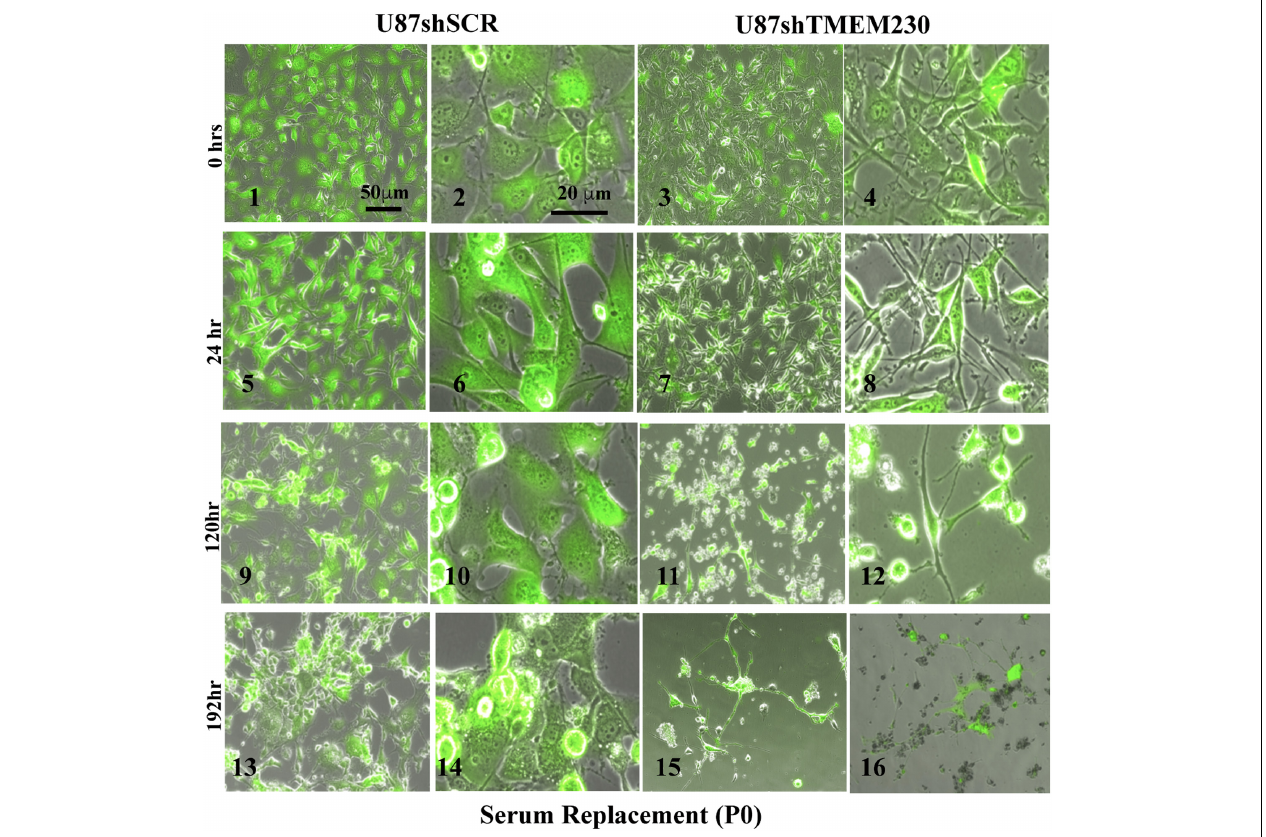
FIGURE 4 | Downregulation of endogenous TMEM230 was sufficient to promote loss of U87-MG substratum adhesion capacity in serum replacement containing media. Control (U87shSCR) and U87 cells in which TMEM230 was constitutively downregulated (U87shTMEM230) were cultured in serum replacement (SR) containing media (P0). Equal number of control cells and cells in which TMEM230 was downregulated were plated in SR containing culture media and monitored over 192 h, starting from when GFP expression was first observed (0